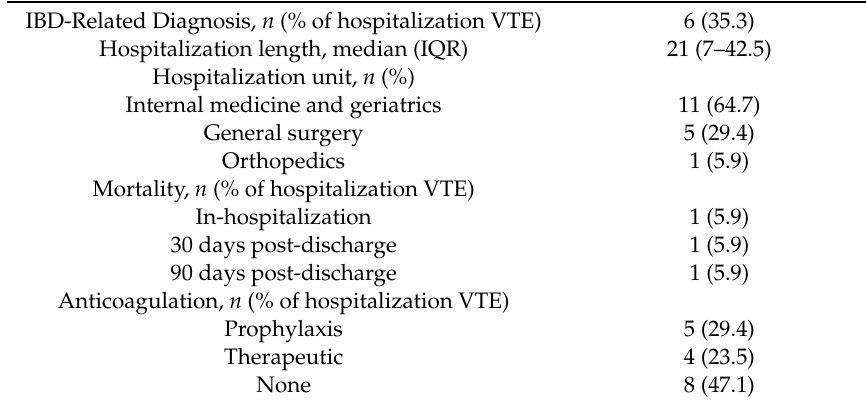
Table 3. Newly diagnosed VTE during